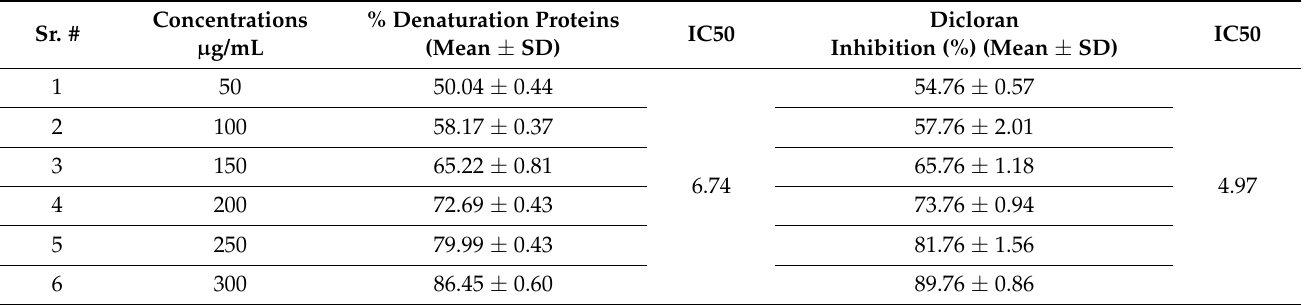
Table 6. Percentage inhibition of protein denaturation of NPs of aqueous fraction of L. edodes. The values are expressed as the Mean ±